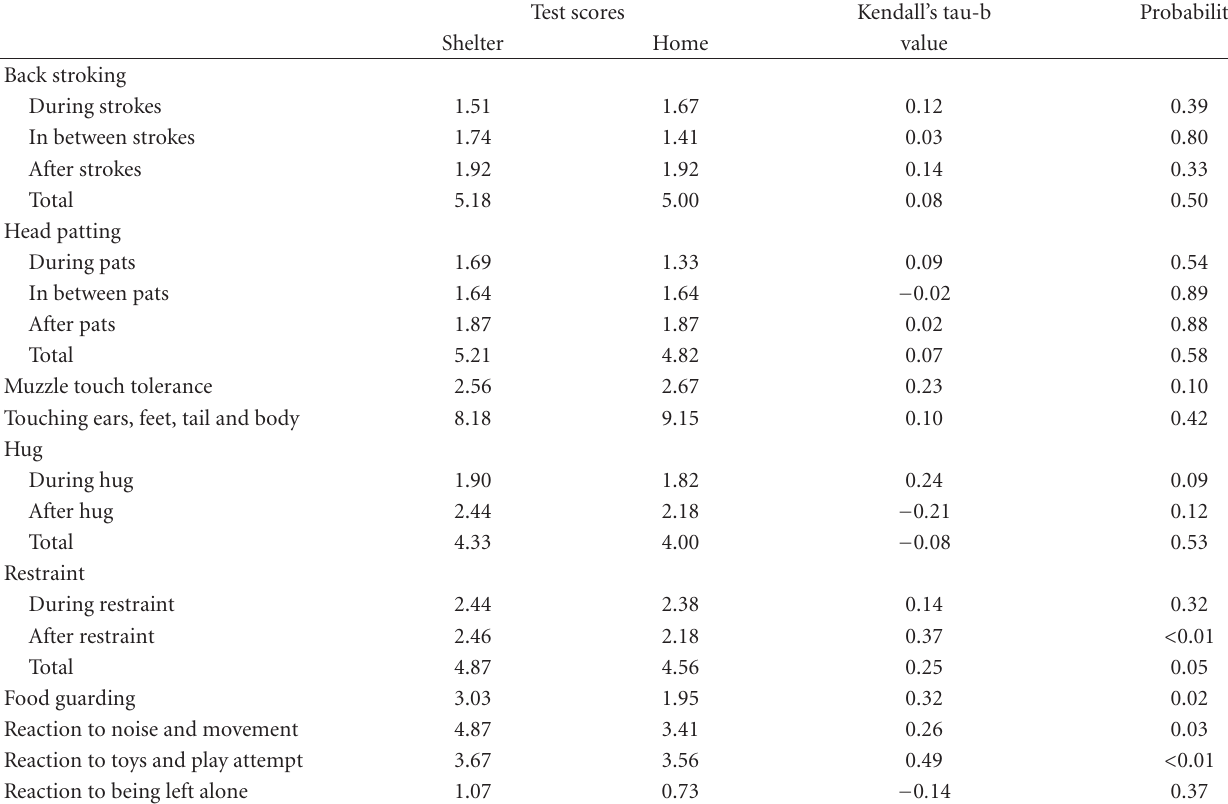
Table 4: Mean scores, Kendall tau B values and probability of significant correlation for the di ff erent tests of the first (shelter) and second (home)